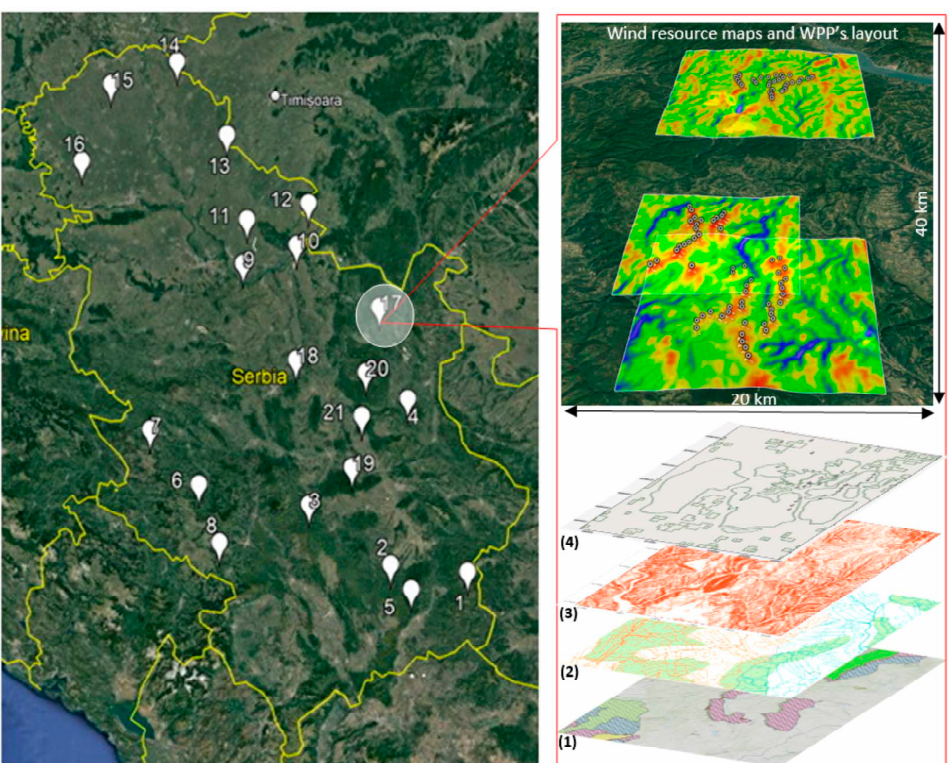
Figure 3. Positions of the measuring points in the identified windy regions in Serbia (denoted by numbers 1–21) with the illustration of the wind energy potential estimation for a single target re- gion. Layers: (1) Nature protected areas, (2) Urbanism and infrastructure, (3) Orography, (4) Rough- ness.